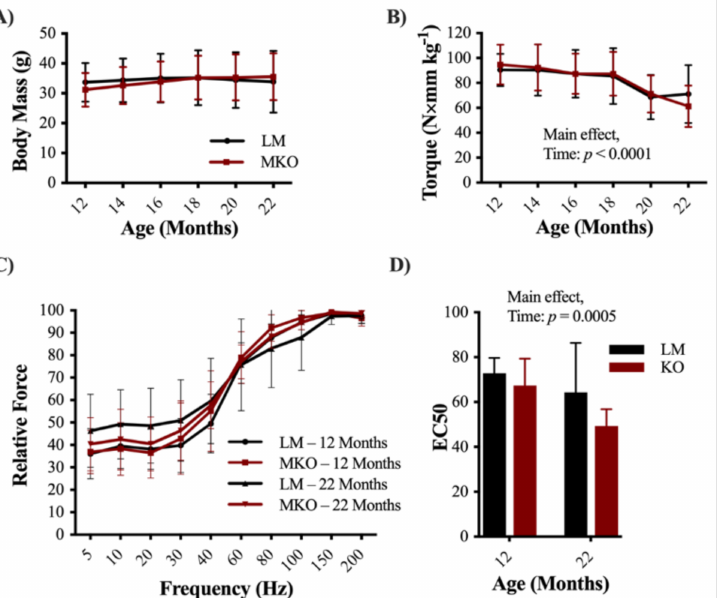
Figure 1. Decline in skeletal muscle function with age ( A ) Average longitudinal body mass measure- ments of Ulk1 muscle-specific Ulk1 knockout mice (MKO) mice and littermate controls (LM) controls starting at 12 months of age through 22 months. ( B ) Average longitudinal in vivo muscle peak torque measurements for 12–22 months of age. ( C ) Relative force frequency of LM and MKO mice at 12 and 22 months of age. ( D ) EC50 calculated from longitudinal force frequency measurements at 12 and 22 months of age. All data are presented as mean ± SD n = 10 mice. Main effects are listed where